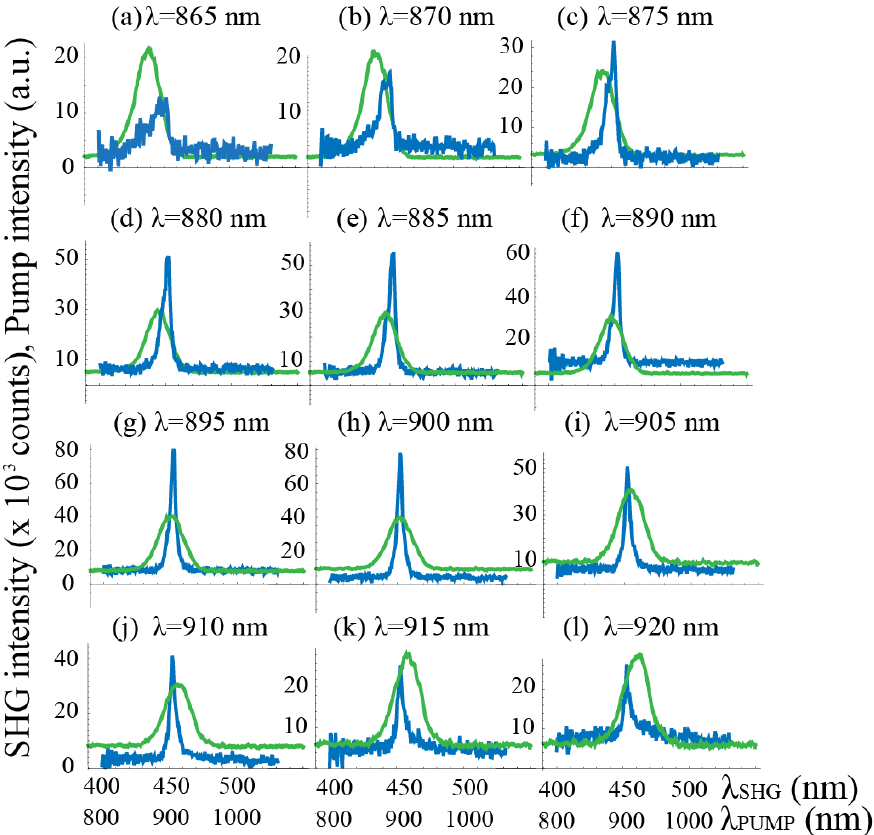
Figure 4. SHG signal counts (blue) measured in 10 min from a 1 mm long GaN waveguide at different central wavelengths of the pump (green). Note the different wavelength scale for the pump and SHG.